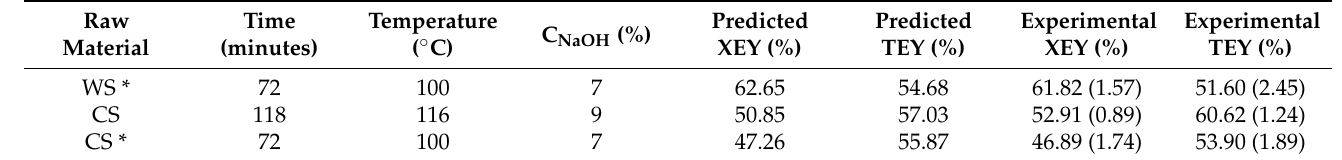
Table 6. The comparison between the model predicted and optimal experimental